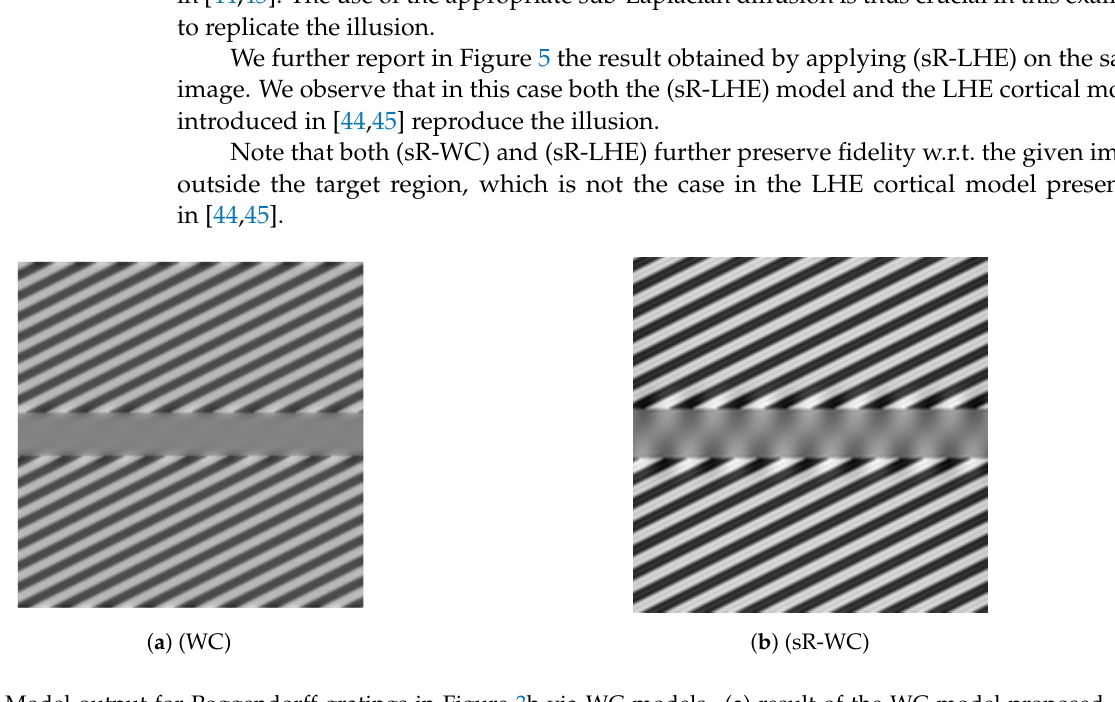
Figure 4. Model output for Poggendorff gratings in Figure 3b via WC models. ( a ) result of the WC model proposed in [44,45]. ( b ) result of (sR-WC) with parameters λ = 0.01, α = 20, σ µ = 6.5, ∆ t = 0.1, ∆ τ = 0.01, τ = 5.